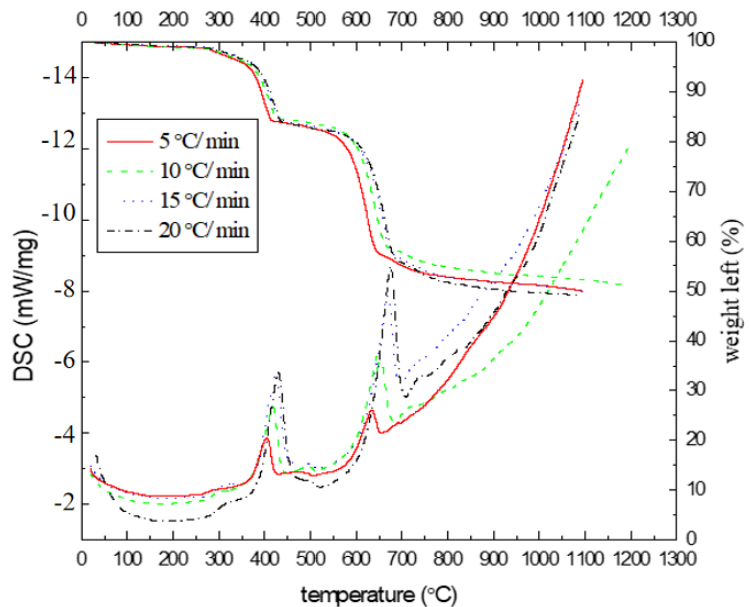
Figure 4. TG and DSC curves of